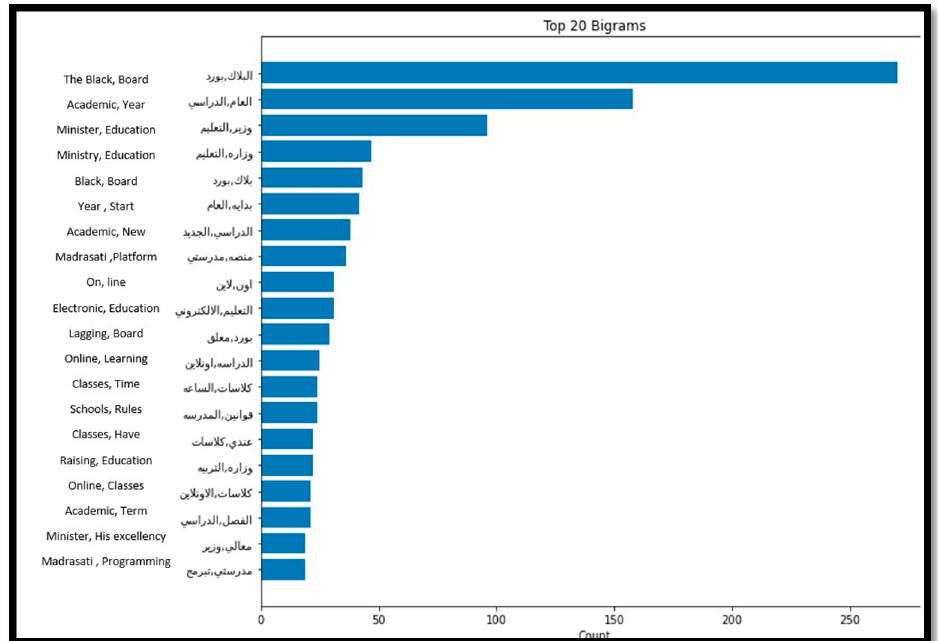
Figure 8. Top 20 Frequent words from the unspecified negative tweets.